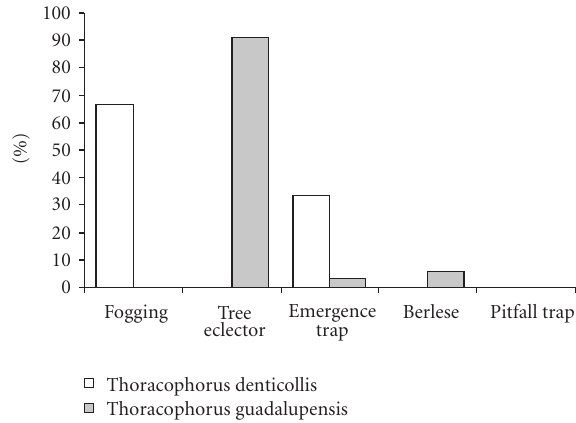
Figure 6: Fractions of specimens found by di ff erent methods in the Central Amazonian Varzea forest of Ilha de Marchanteria of the two Thoracophorus